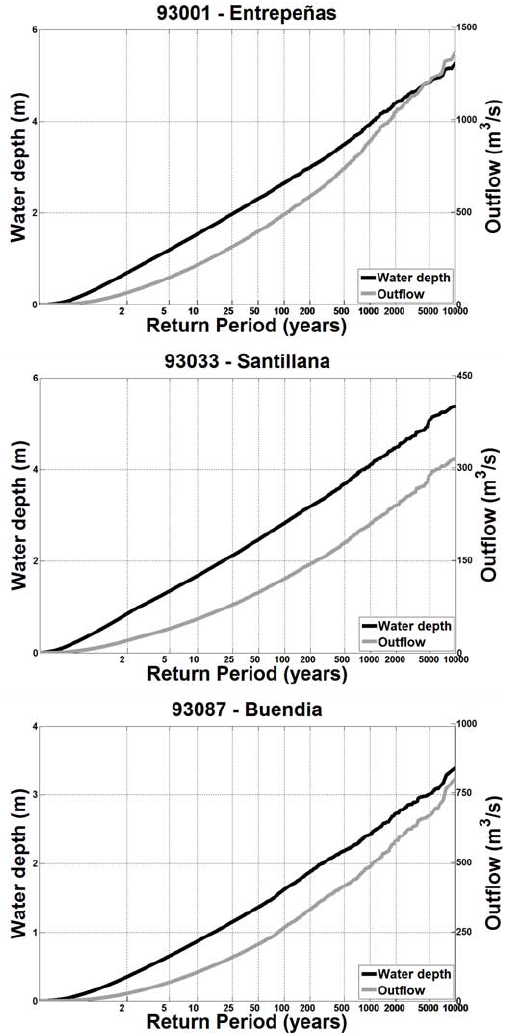
Fig. 9. Frequency curves of the water level over the spillway crest and release.